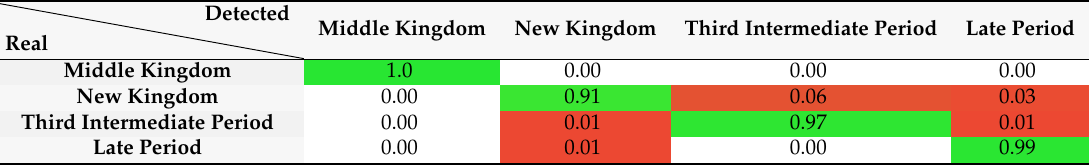
Table 5. Confusion matrix of the period detection of the FN + HN model (%). The green cells represent success in the period detection. The redder the cells are, the bigger error in the period classification. Detected Middle Kingdom New Kingdom Third Intermediate Period Late Period Real Middle Kingdom 1.0 0.00 0.00 0.00 New Kingdom 0.00 0.91 0.06 0.03 Third Intermediate Period 0.00 0.01 0.97 0.01